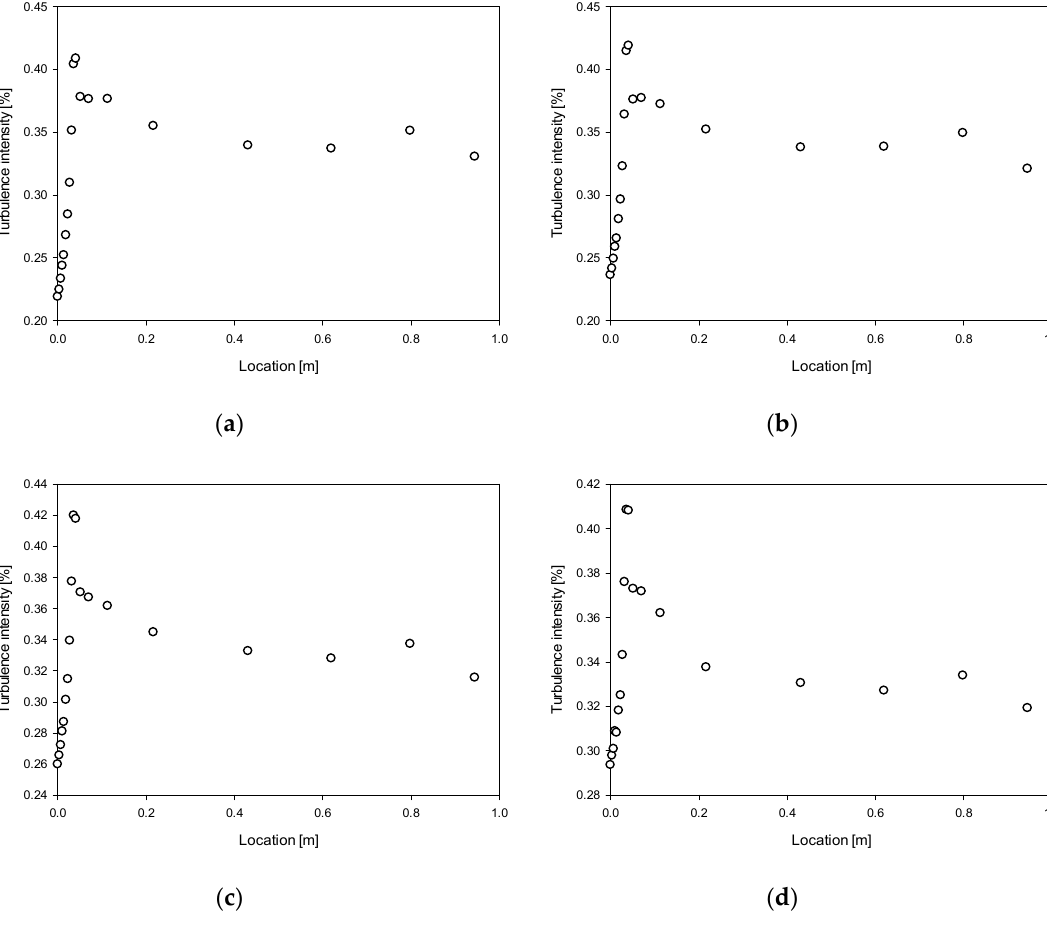
Figure 7. The turbulence intensities obtained by SST model at different times: ( a ) 150 s, ( b ) 250 s, ( c ) 350 s, ( d ) 500 s (Location 0: discharging point).